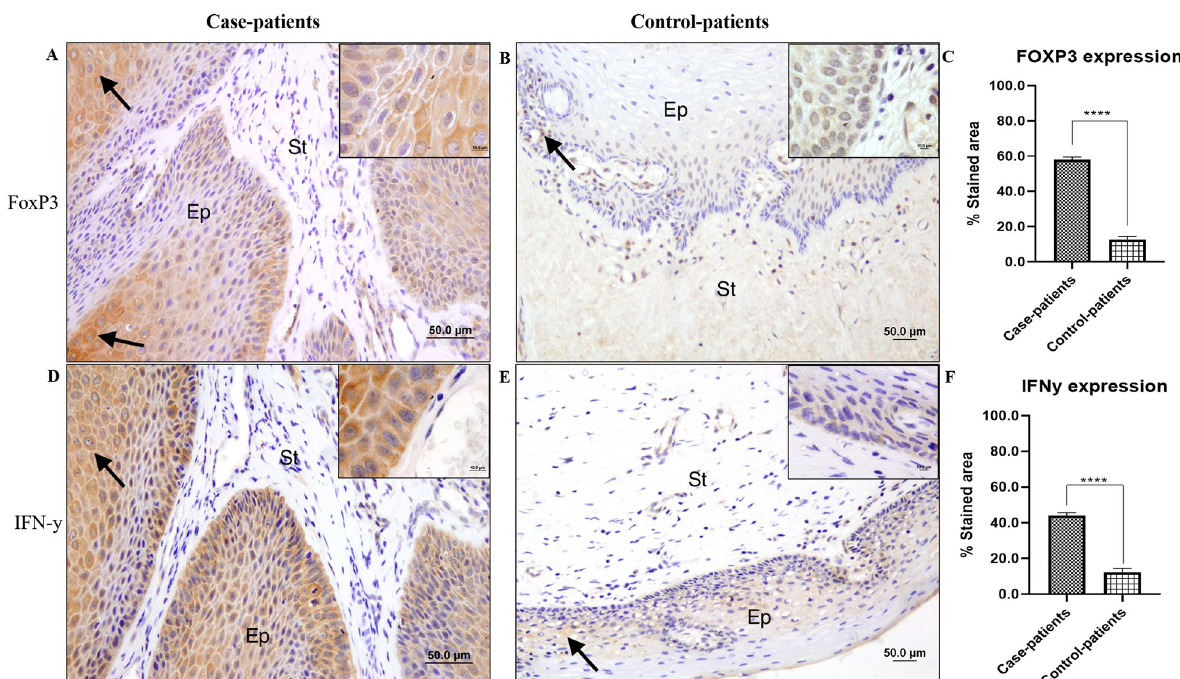
Fig 3. Immunohistochemical assays. Photomicrographs and graphics showing the cytoplasmatic expression pattern of FOXP3 (A-C) and IFN- γ (D-F). Scale bars: 50 μ M in the main pictures and 10 μ M in the insets. ANOVA was followed by the Tukey‘s Multiple comparison test ( ± S.E.M. **** = p < 0.0001). Arrows: positive immunostaining for different markers; Ep: stratified squamous epithelium; St: connective tissue stroma of the dermis.